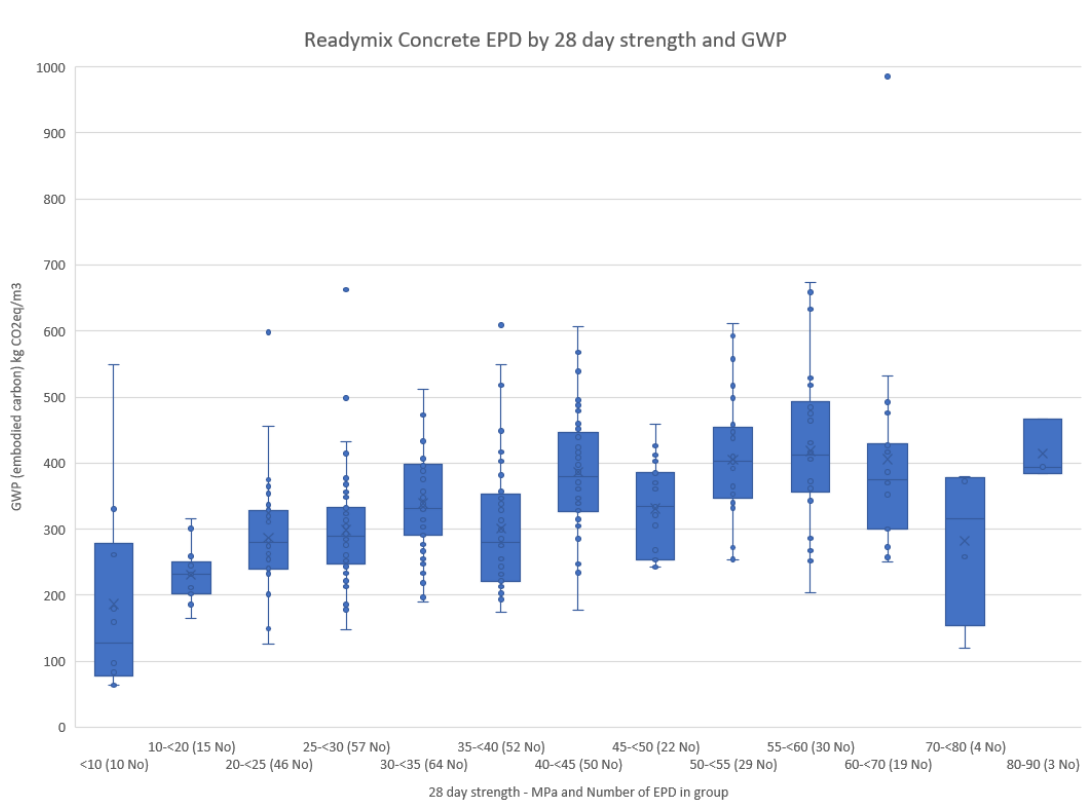
Figure 3. Box and Whisker graph showing mean, upper and lower quartiles of Embodied Carbon for ready-mix concretes from concrete EPD, by 28-day strength, source [7].